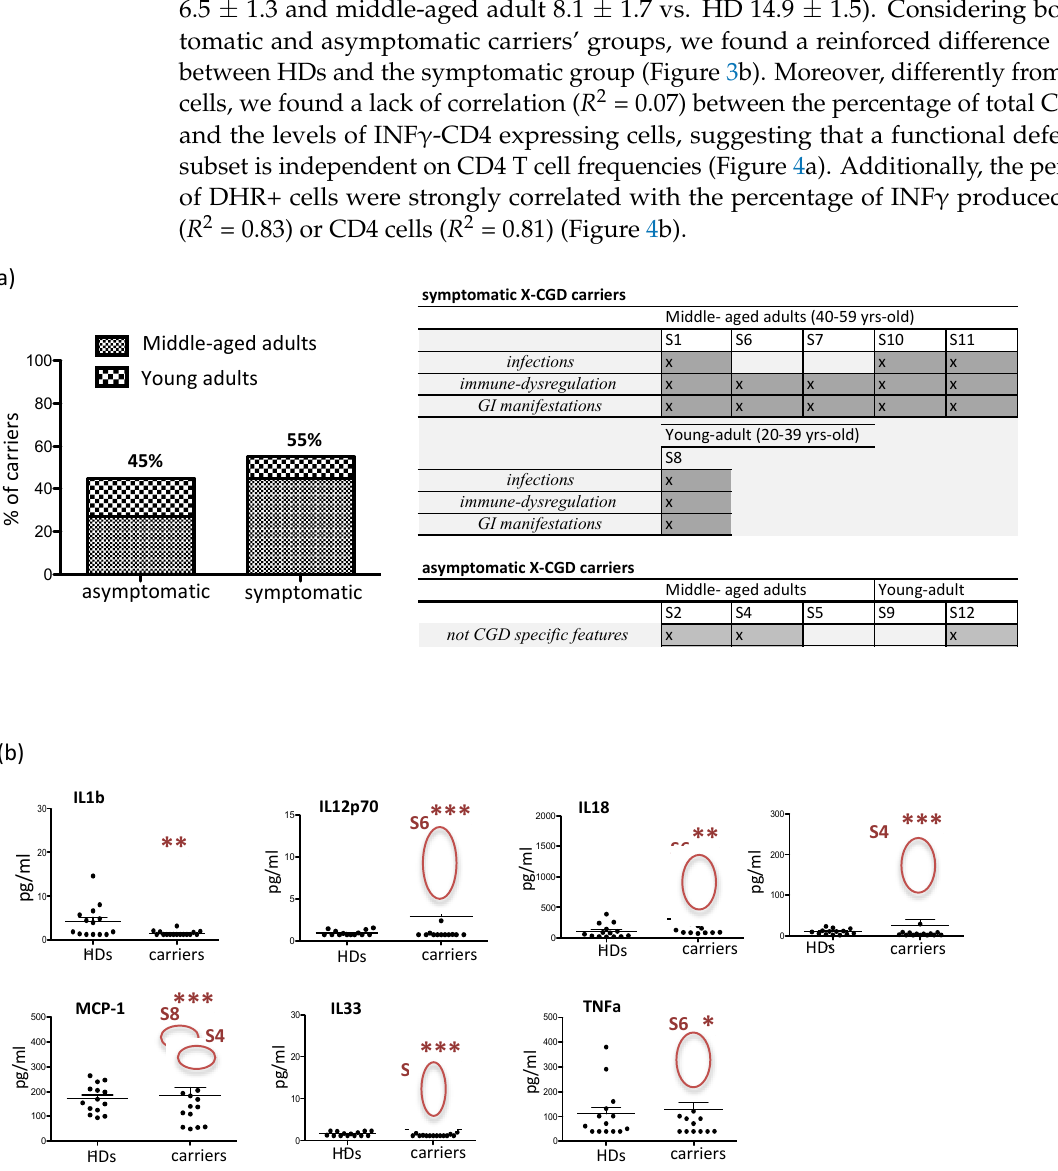
Figure 2. Clinical manifestations in X-CGD. ( a ) Left panel shows the percentage of symptomatic and asymptomatic carriers; right panel illustrates distribution of different clinical features according to age; ( b ) plasmatic pro-inflammatory profile. Each point shows a single female subject. Circles include X-CGD carriers that deviate from average, thus resulting statistically significant. Statistical test used for the data analysis was one-way ANOVA with Dunnett’s post-test considering * p < 0.05, ** p < 0.01 and *** p < 0.001.